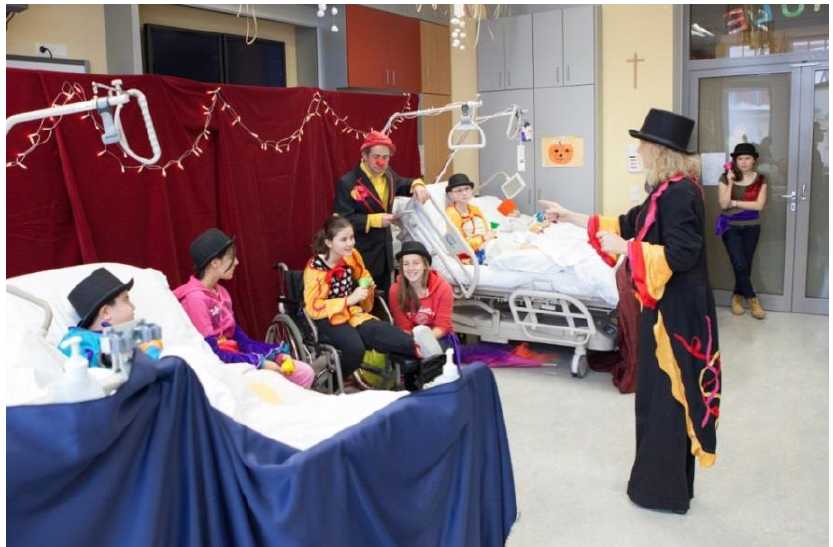
Figure 2. Performance of Circus Patientus in